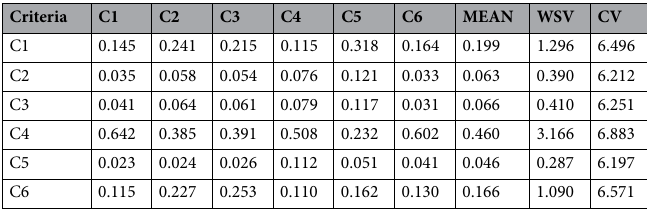
Table 8. The normalized comparison matrix of the SF-AHP